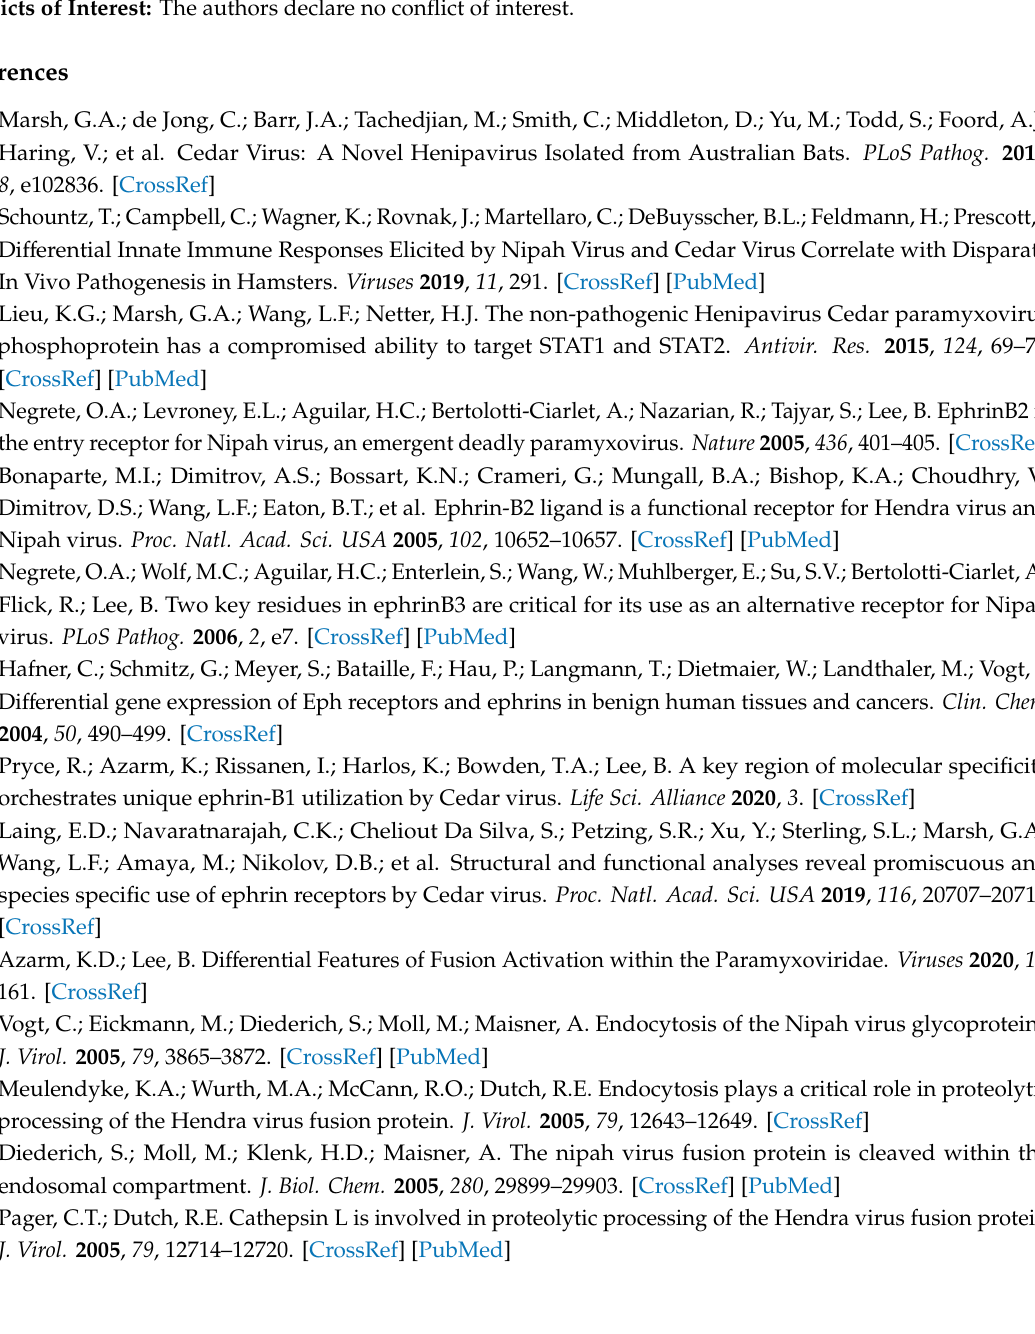
Figure S1: Proteolytic processing of CedV F wt and mutants e8 (e3 + e4) and e9 (e3 + e5), Figure S2: Proteolytic processing of CedV F protein is inhibited by chlorpromazine, Figure S3: Co-expression of CedV F wt, mutants and CedV G protein on the cell